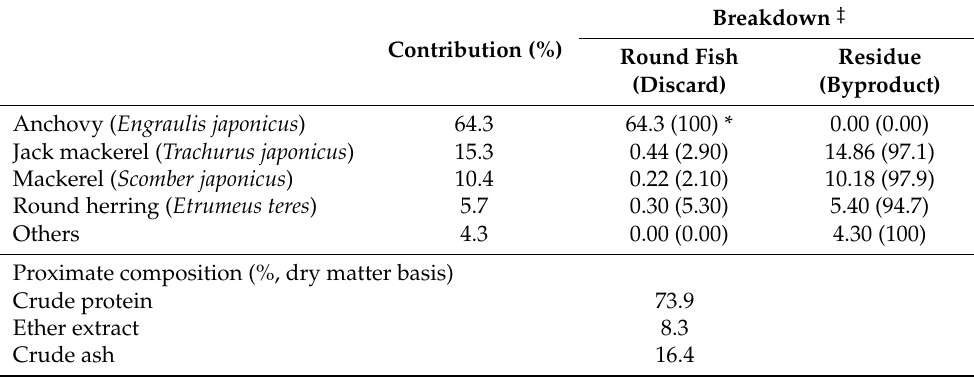
Table 1. Relative contribution (%) of residues and whole-fish from different species in the fish residue meal used in Trial